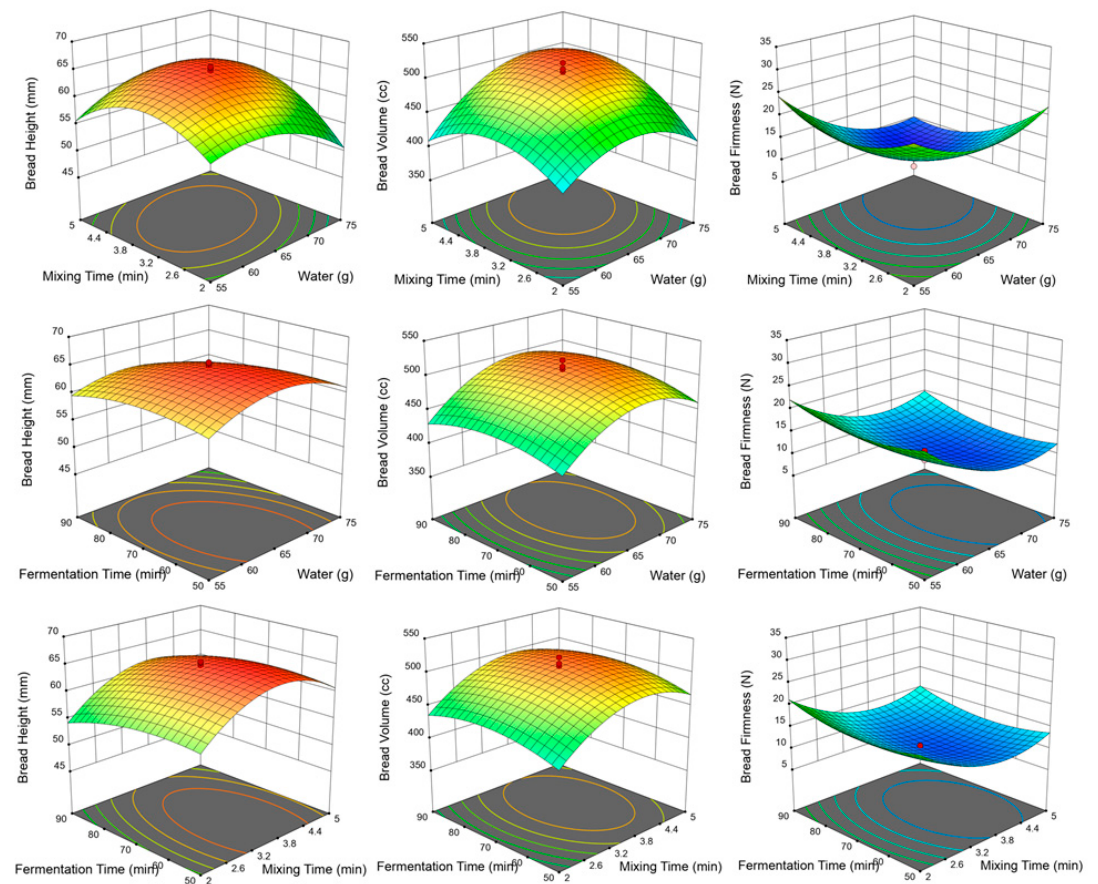
Figure 6. Three-dimensional plots on the three representative quality characteristics of bread affected by significant factors of the formula and processing conditions in the preparation of bread with flour–bran blend at 30% bran.